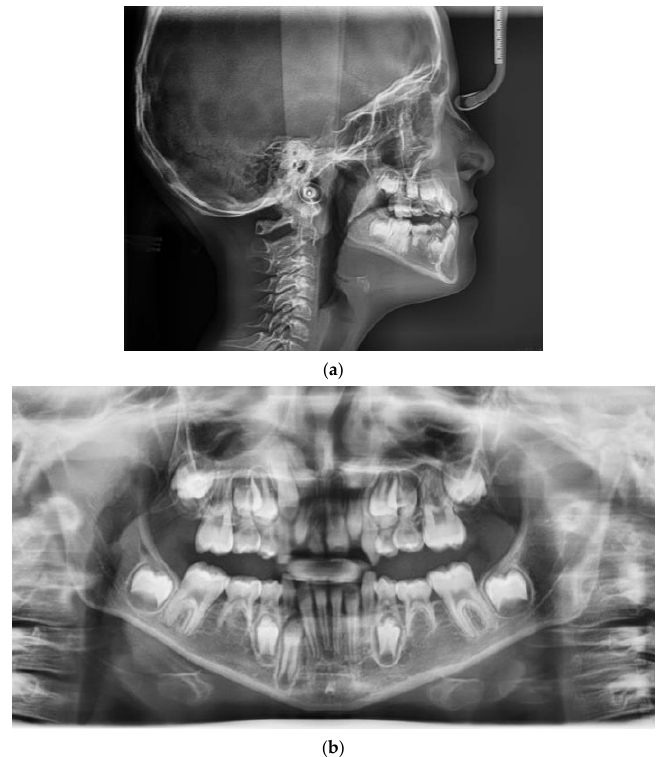
Figure 7. Post-treatment radiographic records: ( a ) lateral cephalogram; ( b )